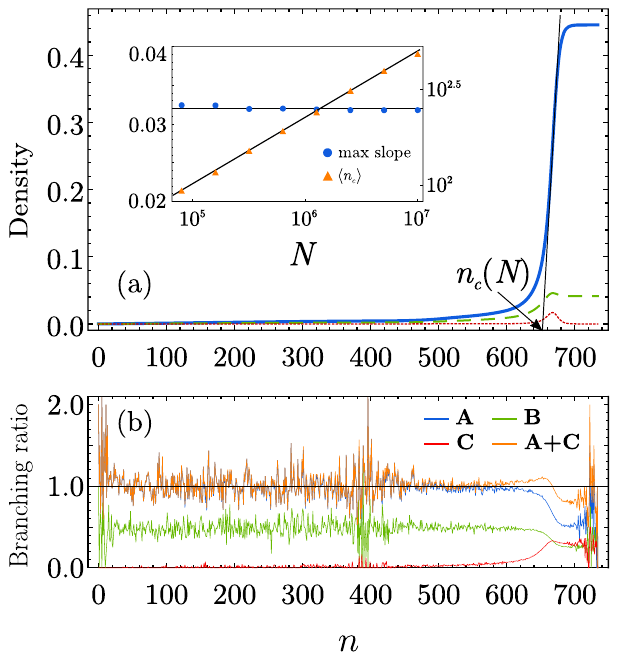
Figure 1. Evolution of the fractions of nodes in each state and of each reaction type. ( a ) Plot of the fraction of nodes in states R (blue, solid curve), W (green, dashed curve) and I (red, dotted curve) as a function of generation n . Inset: Plot of the maximum slope of the curve R ( n ) vs N ( • ) (left vertical axis). The maximum slopes are independent of N . Plot of the characteristic time n c ( N ) vs N ( Δ ) (right vertical axis). The fitted straight line has slope 0.35. ( b ) Plot of the branching ratios as a function of generation n for several types of reactions. Here A (B) represents the mean number of offspring that change their state from S to I ( W ) by the their parents in state I each reaction S + I → 2 I ( S + I → W + I ). C represents the mean number of offspring that change their state from W to I by the reaction W + I → 2 I . For both ( a , b ), data are obtained from a single realization of an infinite avalanche on an ER network with mean degree z = 8 of system size N = 5.12 × 10 6 using the coefficients κ = 1/8, μ = 1/16 and ν =